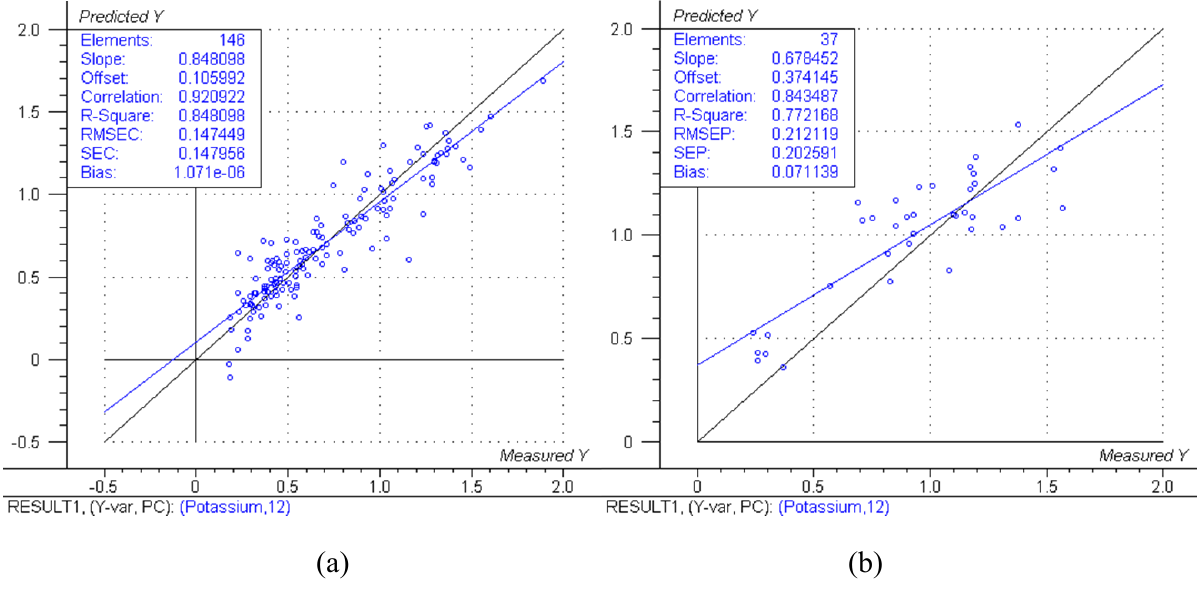
Figure 3. Predicted vs. reference plots and model data for: (a) Potassium calibration. ( b ) Potassium validation. The black lines represent the ideal 1:1 relationship between reference and predicted measurements, the blue lines represent the actual regression lines calculated in each calibration or validation.